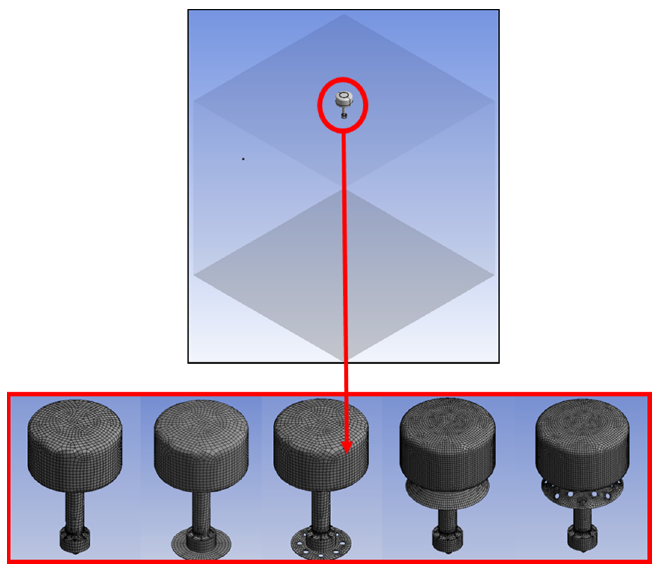
Figure 12. Computational domain and panels of the lightweight light buoys for potential-based simulations.